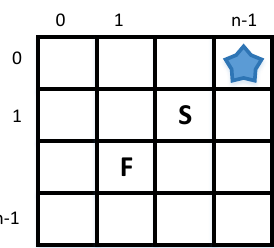
Figure 6. An example state of a 2D shepherding problem with n = 4. In this example, r f = 2, c f = 1, r s = 1 and c s =